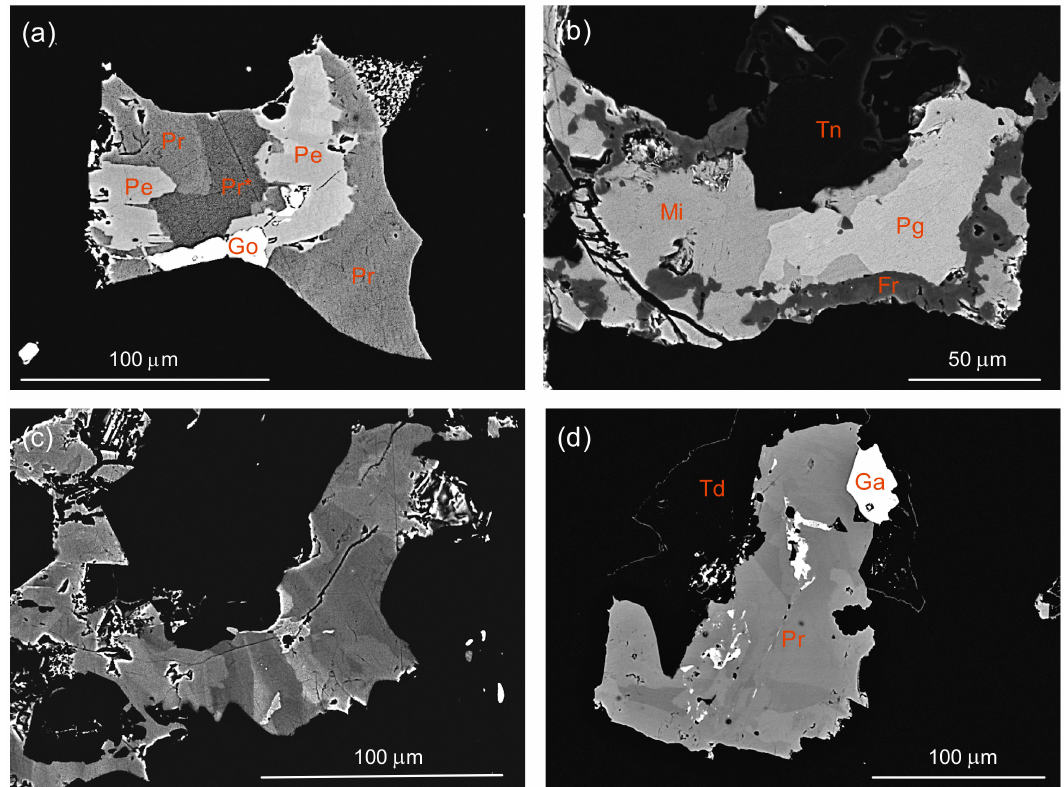
Figure 10. ( a ) Se-rich proustite (Pr) and Se-free proustite (Pr*) intergrown with pearceite (Pe) and gold (Go); ( b ) pyrargyrite (Pg) associated with miargyrite (Mi), freibergite (Fr), and Ag-rich tennantite (Tn); ( c ) aggregates formed by members of pyrargyrite–proustite solid solution; ( d ) proustite aggregates with variable Sb and Se contents in association with galena and Ag-rich tetrahedrite; all back-scattered electron (BSE)